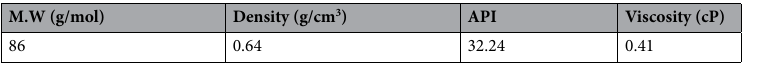
Table 6. The physical properties of crude oil in the